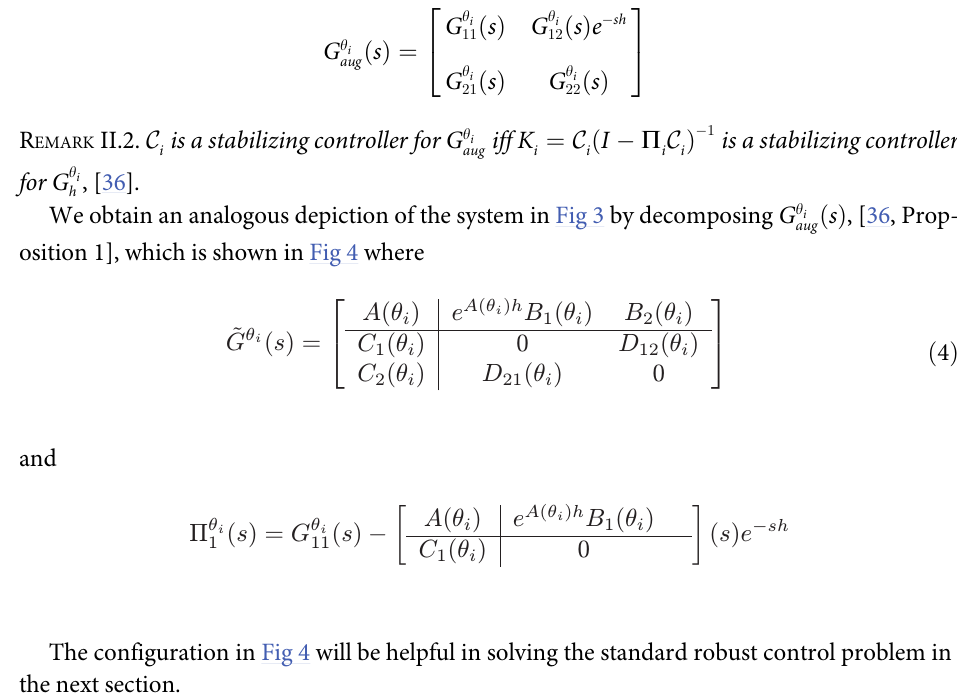
Fig 4. Equivalent representation of the system in Fig 3 by decomposing G y i